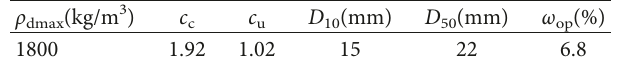
Figure 6: Particle size distribution of the Table 4: Physical parameters of gravel.